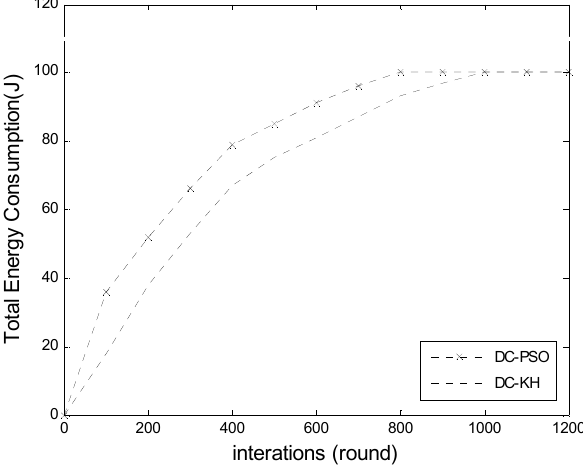
Figure 6. Network total energy consumption comparison chart.